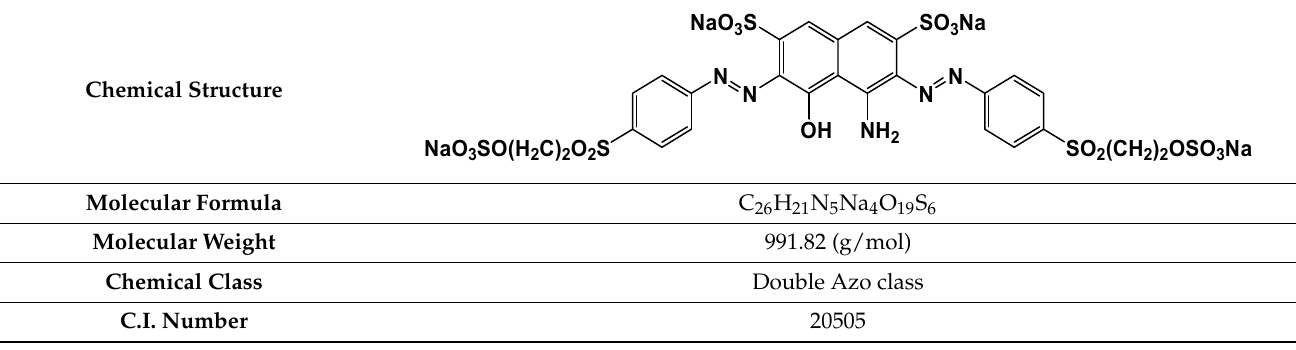
Table 1. The properties of C.I. Reactive black 5.